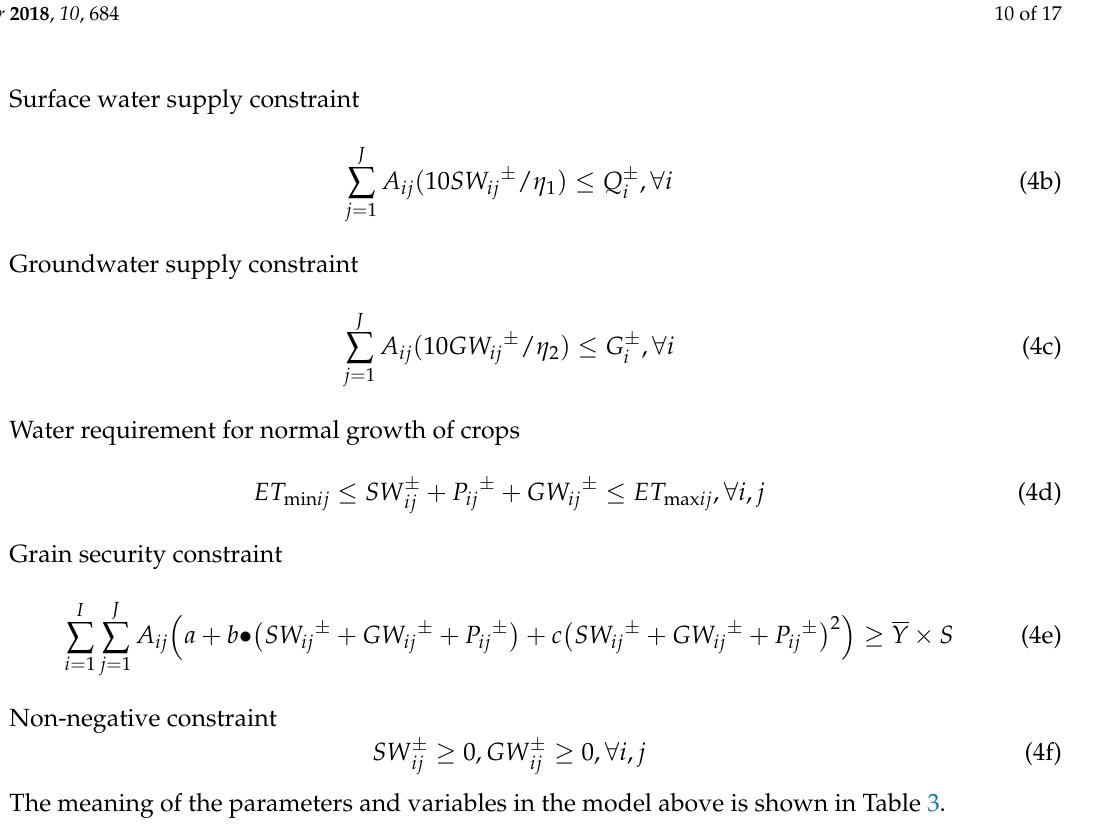
Table 3. Explanation of